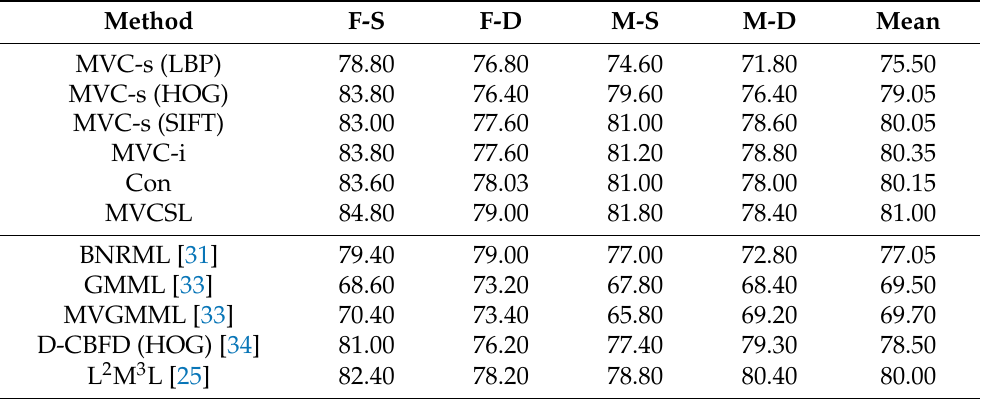
Table 4. Comparisons of mean verification accuracy (%) on the KinFaceW-II dataset under the image-restricted